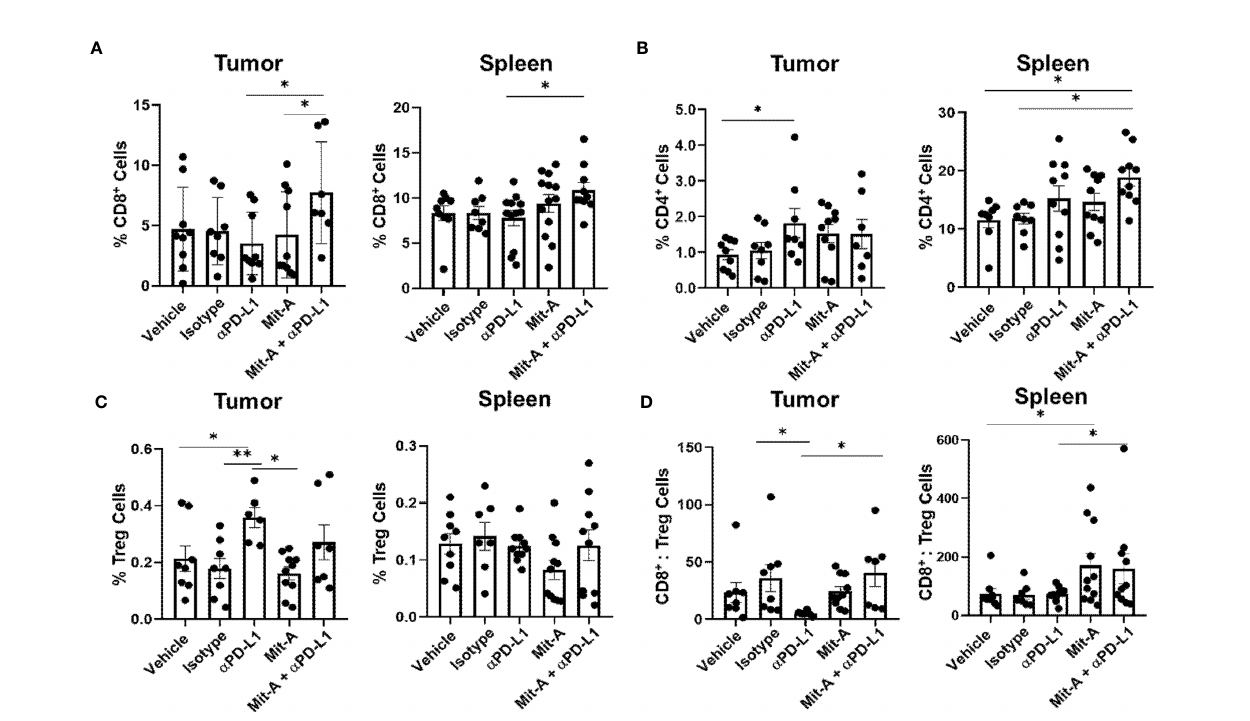
FIGURE 4 | PD-L1 blockade in combination with Mit-A increases T cell in fi ltration and decreases immunosuppressive Tregs. Flow cytometry analysis of tumor and spleen collected from the orthotopic tumor-bearing mice treated with vehicle, Isotype (IgG), Mit-A w/o a PD-L1 mAb. All cell populations were gated out of CD45 + live cells. (A) Percentage of CD8 + T cells (CD3 + CD8 + ) for tumor (left) and spleen (right); (B) Percentages of CD4 + T cells (CD3 + CD4 + ) for tumor (left) and spleen (right); (C) Tregs representing percentage of CD3 + CD4 + CD25 + FoxP3 + for tumor (left) and spleen (right) were analyzed and compared among the treatment groups. (D) CD8 + T cells:Tregs ratio for tumor (left) and spleen (right), respectively shown. Each dot represents one individual mouse. Data pooled of two independent experiments (minimum n = 4 per group for each experiment) and analyzed as mean ± SEM by One-way ANOVA (Fischer ’ s LSD test). *p < 0.05, **p <